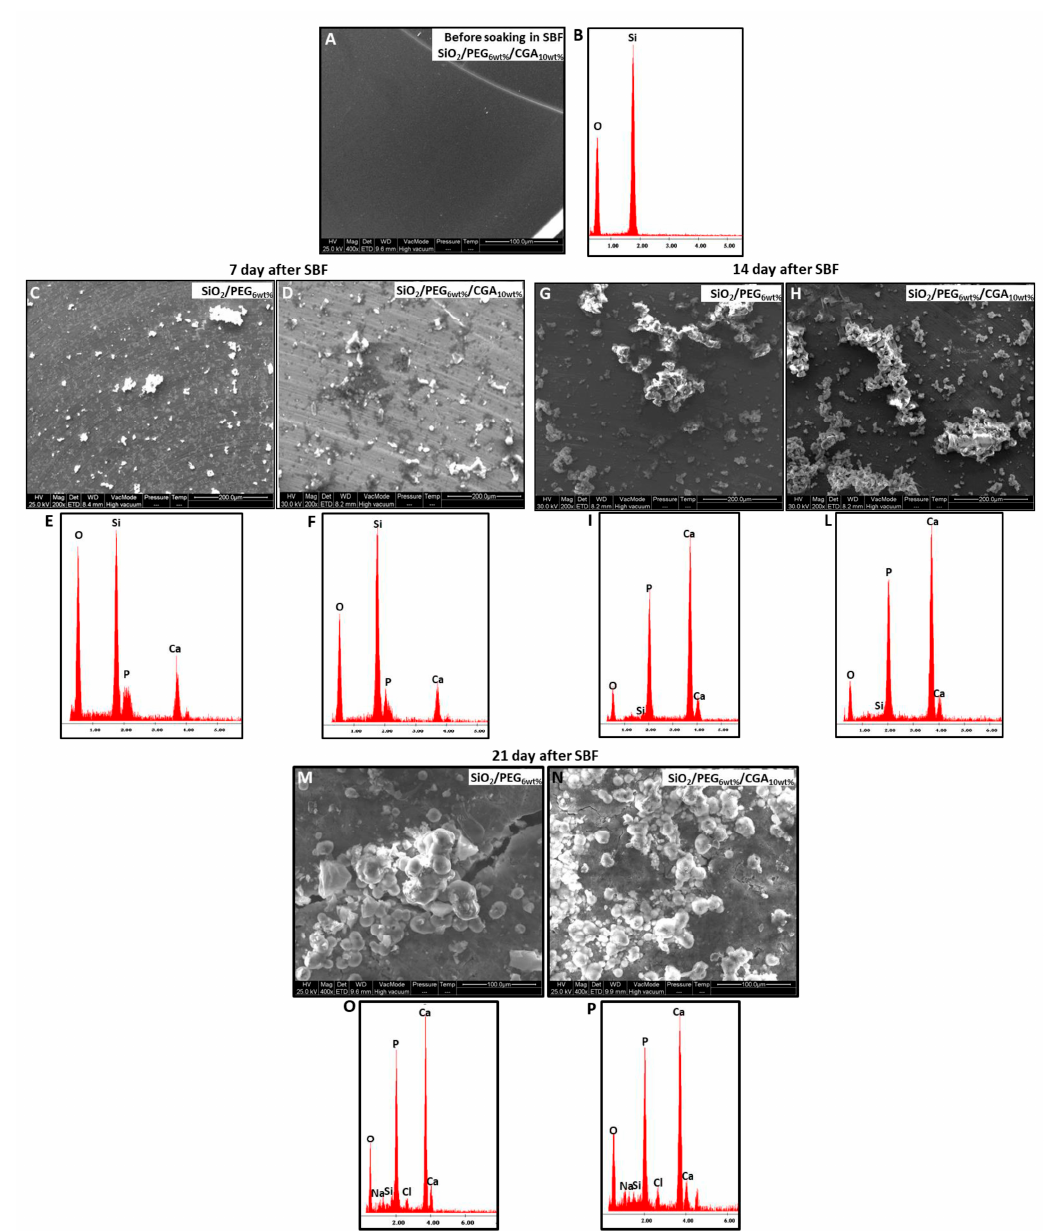
Figure 4. SEM micrographs of ( A ) a representative SiO 2 /PEG 6wt% /CGA 10wt% hybrid ( B ) EDX analysis of SiO 2 /PEG6wt%/CGA10wt% hybrid before exposure to SBF, ( C ) SiO 2 /PEG 6wt% and ( D ) a representative SiO 2 /PEG 6wt% /CGA 10wt% hybrid after 7 days in SBF; ( E ) EDX analysis of SiO 2 /PEG 6wt% hybrid and ( F ) EDX analysis of SiO 2 /PEG 6wt% /CGA 10wt% hybrid after 7 days in SBF. ( G ) SiO 2 /PEG 6wt% and ( H ) a representative SiO 2 /PEG 6wt% /CGA 10wt% hybrid after 14 days in SBF; ( I ) EDX analysis of SiO 2 /PEG 6wt% hybrid and ( L ) EDX analysis of SiO 2 /PEG 6wt% /CGA 10wt% hybrid after 14 days in SBF. ( M ) SiO 2 /PEG 6wt% and ( N ) a representative SiO 2 /PEG 6wt% /CGA 10wt% hybrid after 21 days in SBF; ( O ) EDX analysis of SiO 2 /PEG 6wt% hybrid and ( P ) EDX analysis of SiO 2 /PEG 6wt% /CGA 10wt% hybrid after 21 days in SBF.